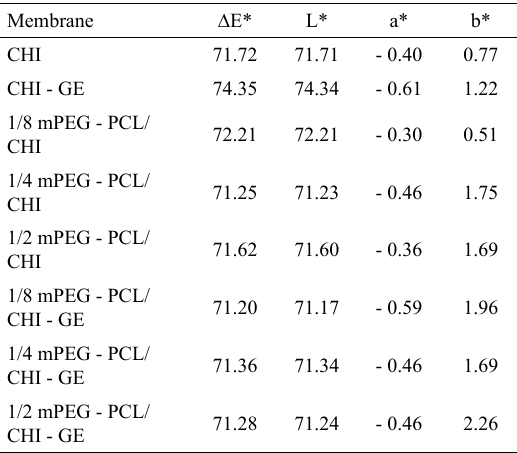
Table 3. Luminescence parameter, L*; chromatic coordinates a* and b* and total color difference ∆E* of membranes unloaded and loaded with